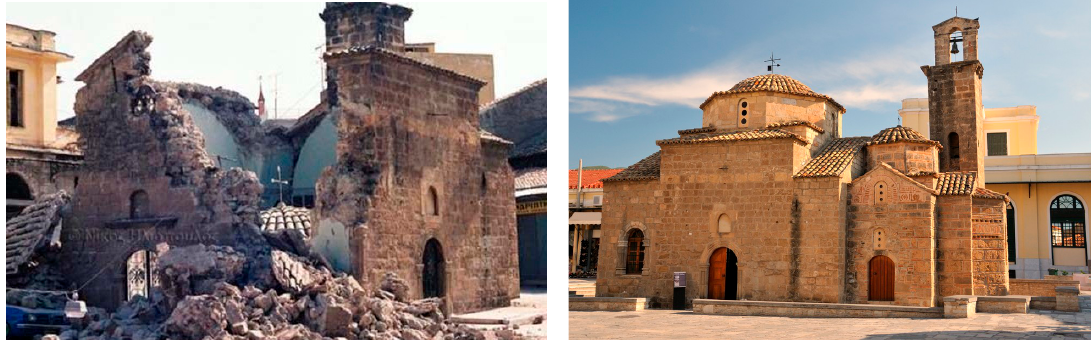
Figure 24. The church of Ipapanti in the centre of Kalamata.